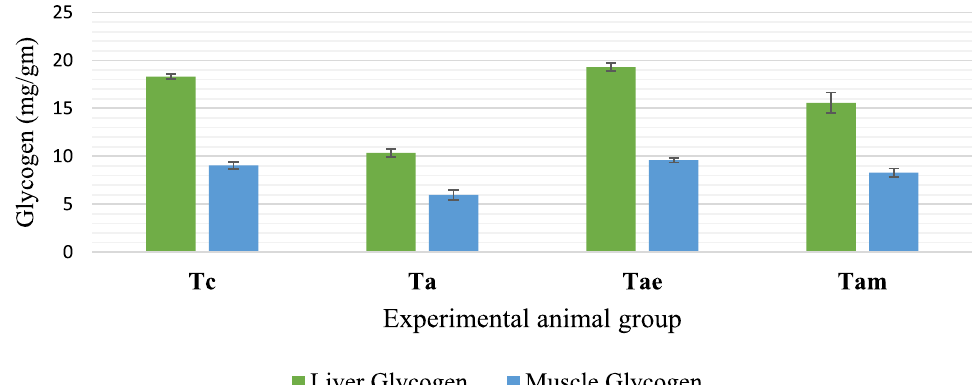
Fig. 3 Effect of mango peel extract and mangiferin on Liver and Muscle glycogen levels in the alloxan-induced type I diabetic rat. Liver and muscle glycogen levels are decreased in Ta group compared to Tc group. In Tam and Tae there was an increase in glycogen content in liver and muscle with the control group (Tc)